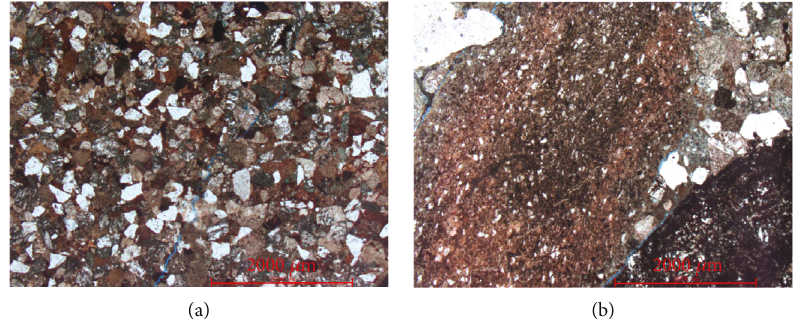
Figure 3: Thin-section observation of compaction features of sandy conglomerates from Triassic Baikouquan Formation in the slope of the Mahu Sag. (a) Pseudomatrix formed by plastic grains deformed under pressure and (b) tight directional arrangement of plastic grains.